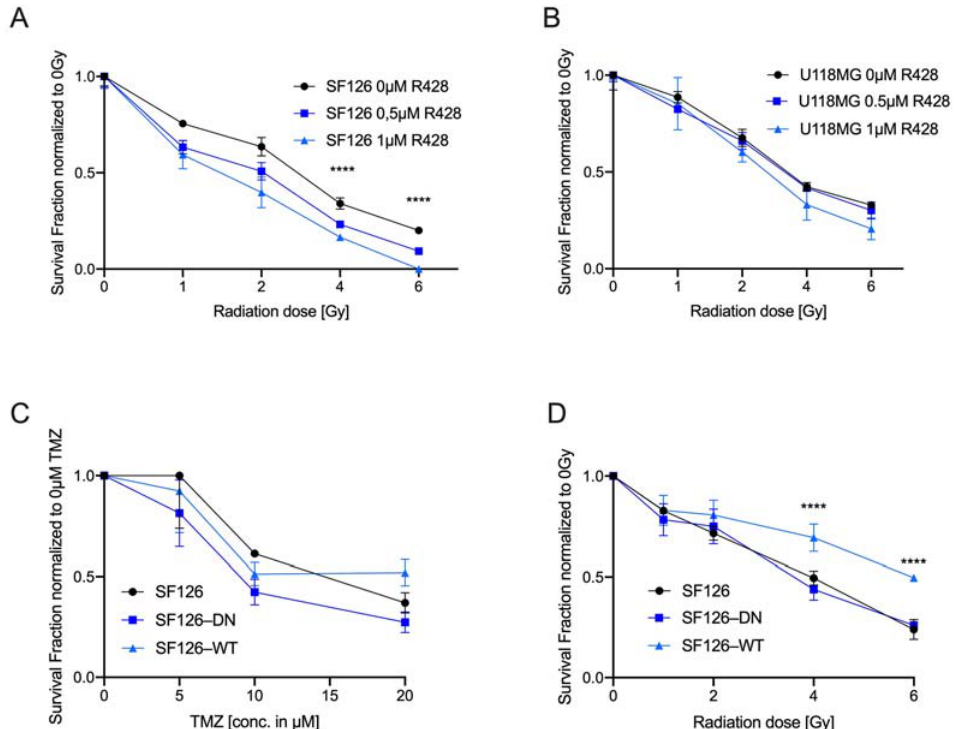
Figure 4. AXL TKI R428 combined with radiation (RTX) increases therapeutic effects and endogenous RTK-AXL overexpression is related to RTX resistance: ( A ) Survival fraction of SF126 under radiation and R428 exposure. Ordinary one-way ANOVA, SF126: **** p < 0.0001; ( B ) Survival fraction of U118MG under radiation and R428 exposure. Ordinary one-way ANOVA, U118MG: p = ns; ( C ) survival fraction of SF126, SF126-DN and SF126-WT cell lines in colony formation assay under increasing dosage of temozolomide (TMZ). Ordinary one-way ANOVA, p = ns; ( D ) survival fraction of SF126, SF126-DN and SF126-WT cell lines in colony formation assay under increasing dosage of radiation (0, 2, 4, and 6 Gy). Ordinary one-way ANOVA, SF126WT at 2 and 6 Gy: **** p < 0.0001.